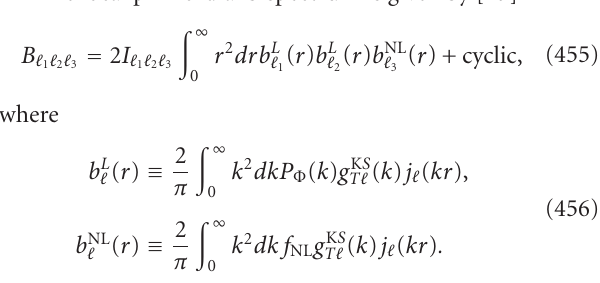
Figure 1: Shape dependence of the second-order bispectrum from products of the first-order terms (top) and that of the local primordial bispectrum (bottom). We show (cid:7) 1 (cid:7) 2 (cid:15) a (1) have the largest signals in the squeezed triangles, (cid:7) 1 (cid:11) (cid:7) 2 ≈ (cid:7) 3